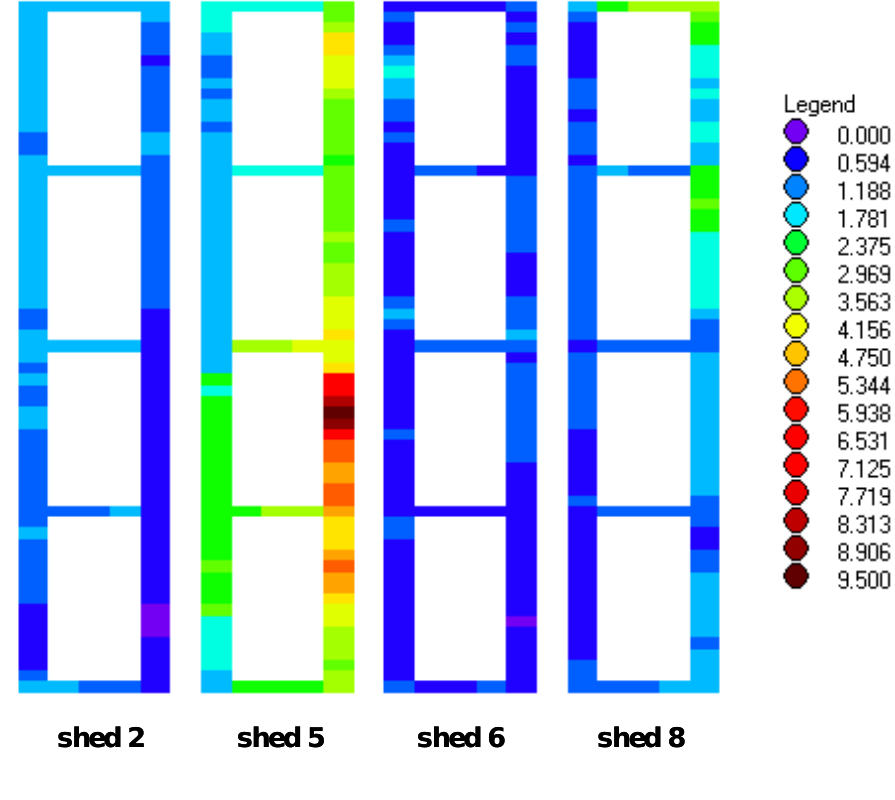
Figure 1. Ammonia concentrations in four sheep buildings. Mean ammonia concentrations mapped at 2 m intervals (n = 48)